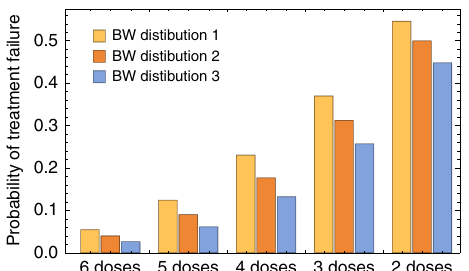
Fig. 3 Model-estimated parasitological treatment failure rates at 28 days after treatment with AL. Results for perfectly-adherent patients (6 doses) are compared with patients who did not complete treatment. The bar marked ‘ 5 doses ’ denotes that only the fi rst 5 doses were taken, ‘ 4 doses ’ that only the fi rst 4 were taken, and so on. In each case we performed simulations for three body-weight distributions. For each bar shown, results were obtained by simulating a cohort of 10 5 patients. Body-weight distribution 1, taken from clinical trials of AL in African children 6 , was the distribution used when fi tting the PD model (mean = 11.1 kg, SD 2.8). We compare the results obtained in that case with two older cohorts: distribution 2 (mean = 17.3 kg, SD = 6), and distribution 3 (mean = 30.0 kg, SD = 10.0). All distributions were Gaussian, truncated so that the